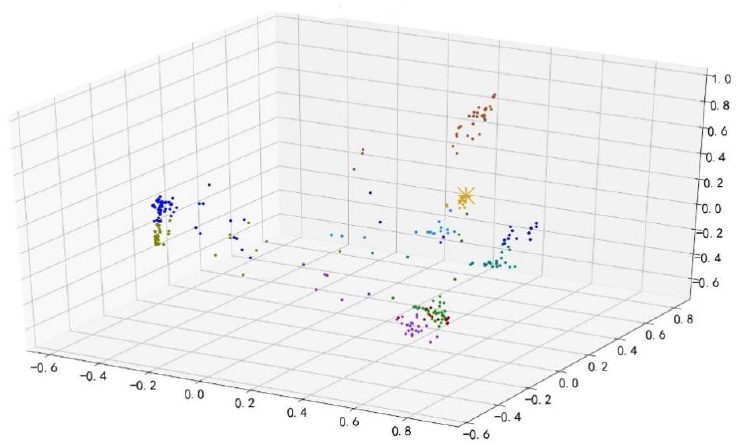
Figure 11. Cluster distribution under k-means (abnormal sample).